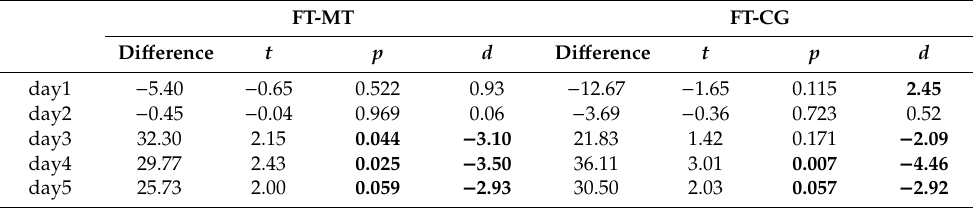
Table A10. Significance and e ff ect sizes for the prominent Deck B phenomenon between